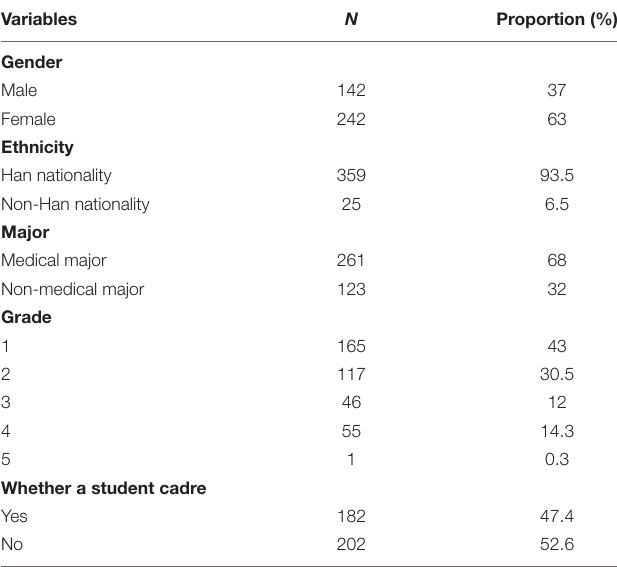
TABLE 1 | Demographic characteristics of